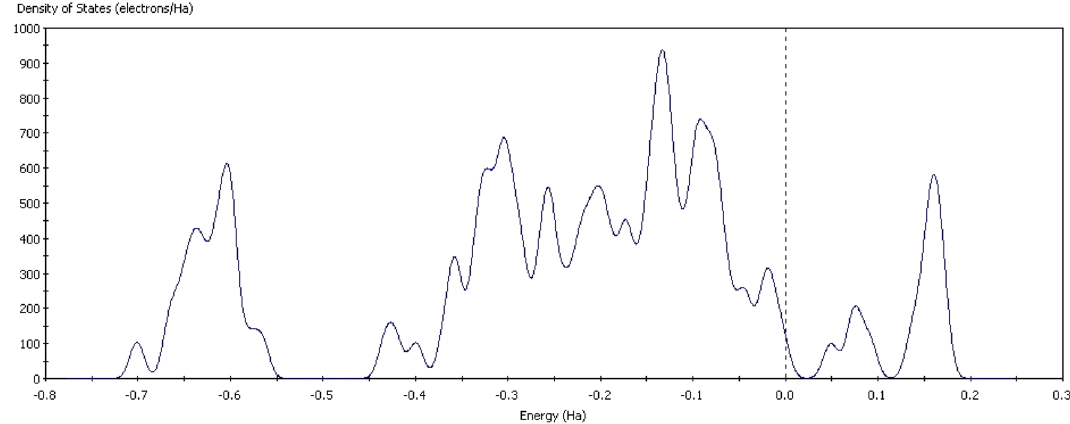
Fig. 3 Total DOS of boron nitride nanosheet (B